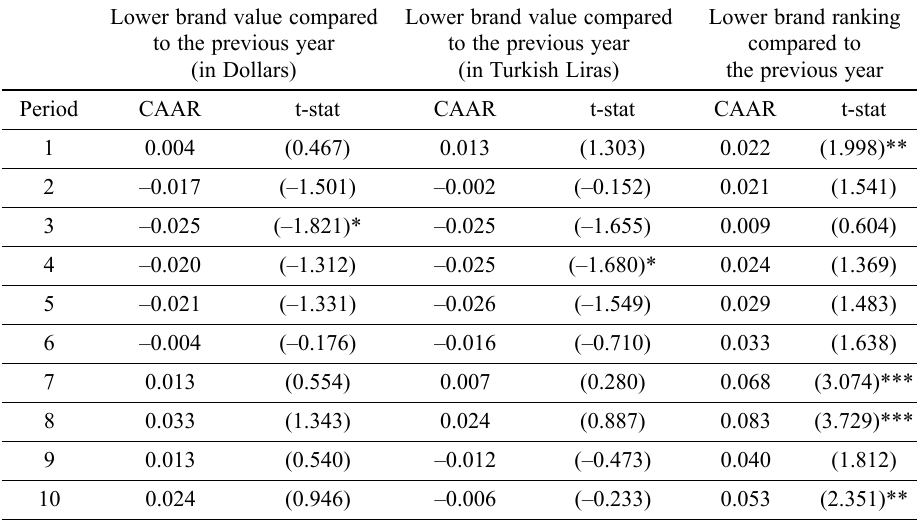
Table 5. Announcement window monthly excess returns of the firms with lower brand values or rankings compared to the previous